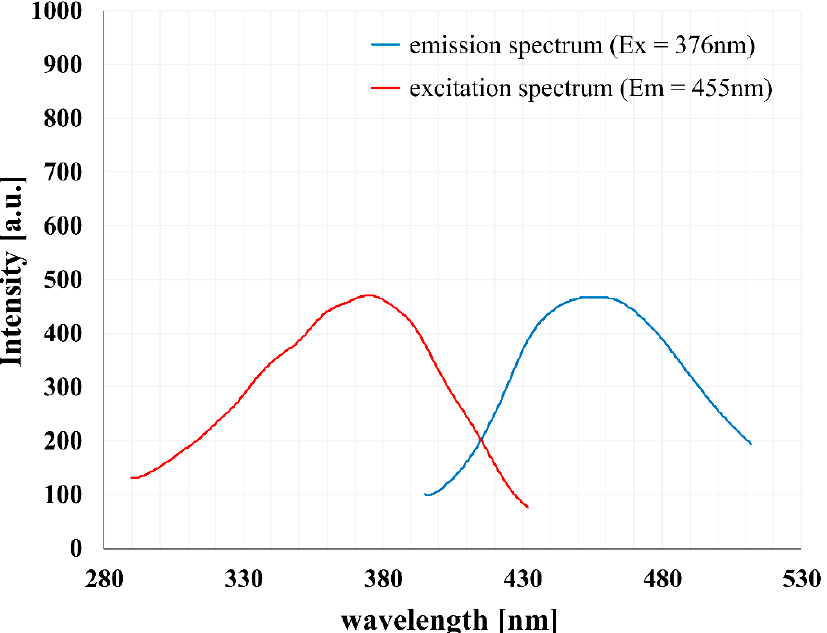
Figure 3. Excitation and emission fluorescence spectra of 1 mg/mL PAMAM [G5:G3-(TREN)]- N -(4- carbomethoxy) pyrrolidone terminated tecto(dendrimer), Structure (C) in PBS.